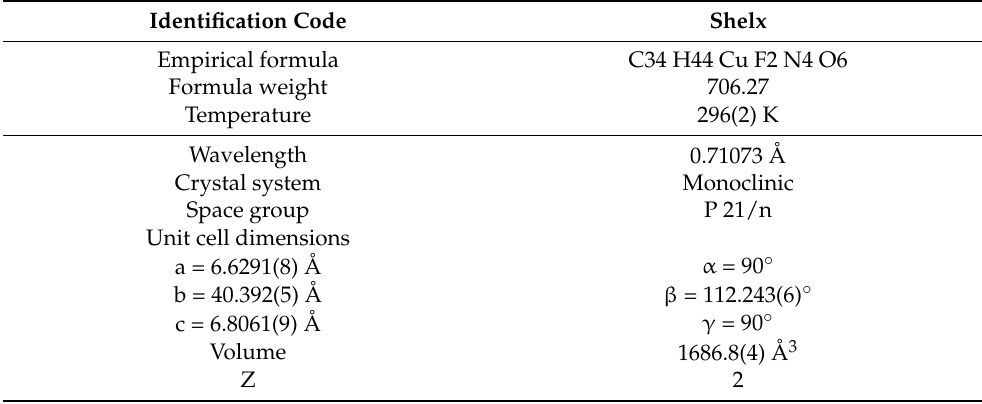
Table 1. Crystal data and structure refinement for